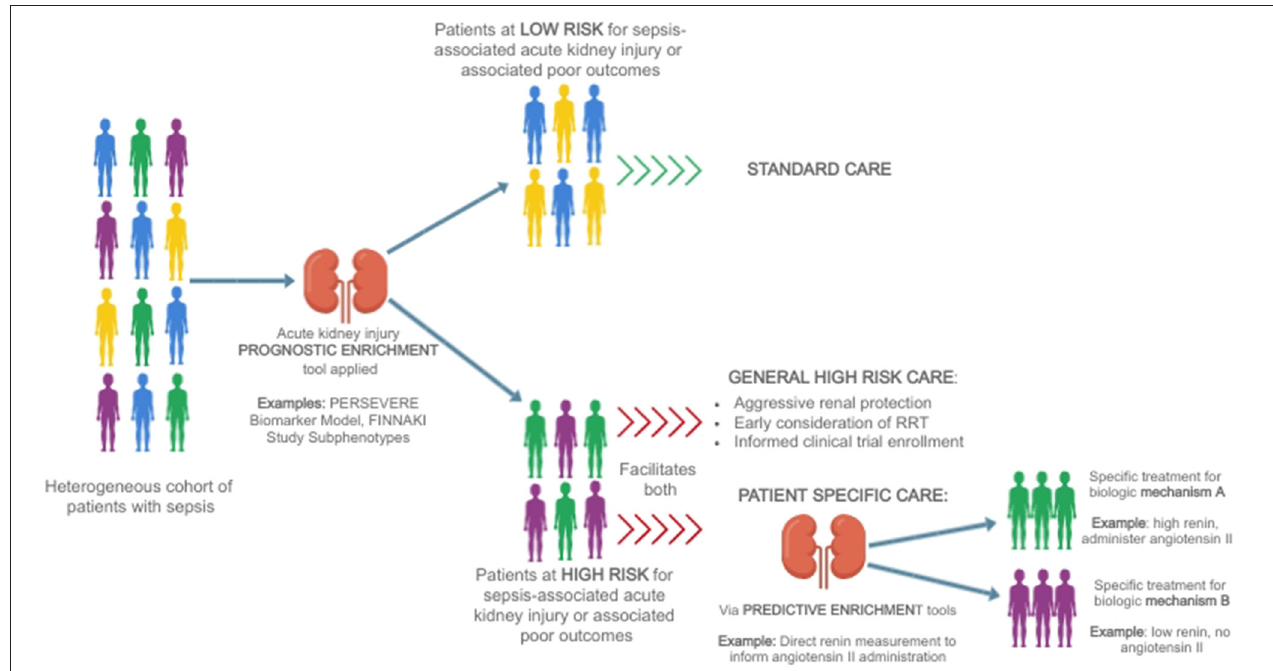
FIGURE 1 | A heterogeneous group of patients with sepsis is divided first using a prognostic enrichment tool into those at high and those at low risk of sepsis-associated acute kidney injury [for example, the PERSEVERE Biomarker Model (64)] or associated poor outcomes such as delayed renal recovery or mortality [for example, FINNAKI Study subphenotypes (65)]. Patients who are at low risk may be treated with standard therapy, while patients at high-risk may receive more aggressive care aimed at renal protection, earlier consideration of renal support in the form of renal replacement therapy, and be considered for informed enrollment in clinical trials aimed at identifying therapies for sepsis-associated acute kidney injury. Ultimately, the goal is to utilize predictive enrichment tools to further subdivide patients on the basis of biology [for example, using direct renin levels to inform the use of angiotensin II (66)], allowing for the implementation of patient-specific